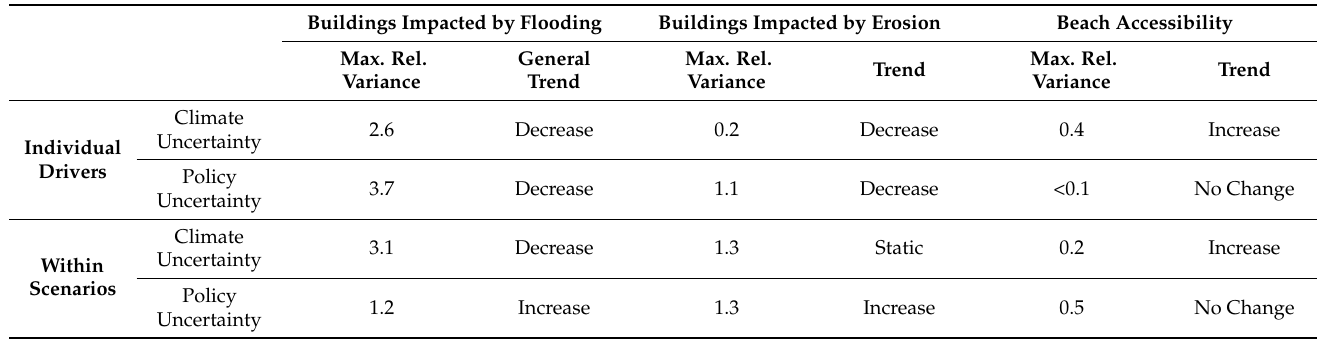
Table 3. Magnitude and trend in relative variance (uncertainty) through